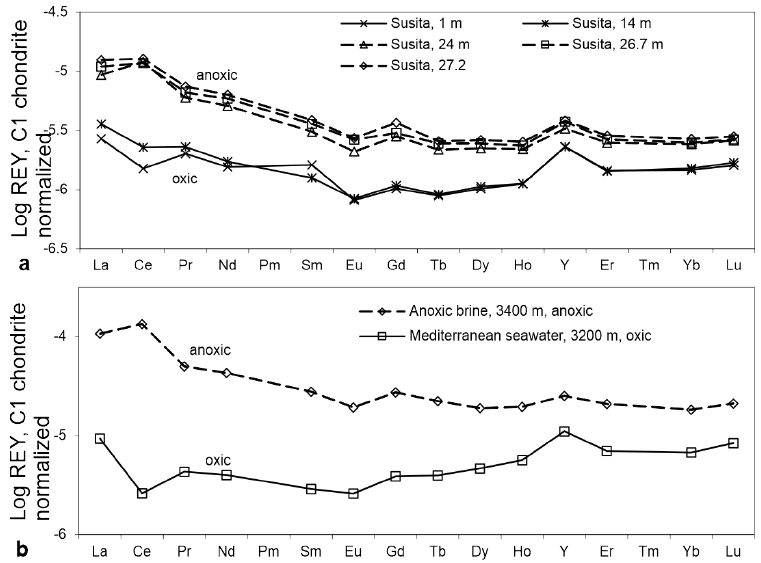
Figure 14. Comparison of REY patterns at surface and bottom conditions passing from oxidizing to reducing conditions in ( a ) Lake Tiberias, Israel [67] and ( b ) in Tyro basin, eastern Mediterranean